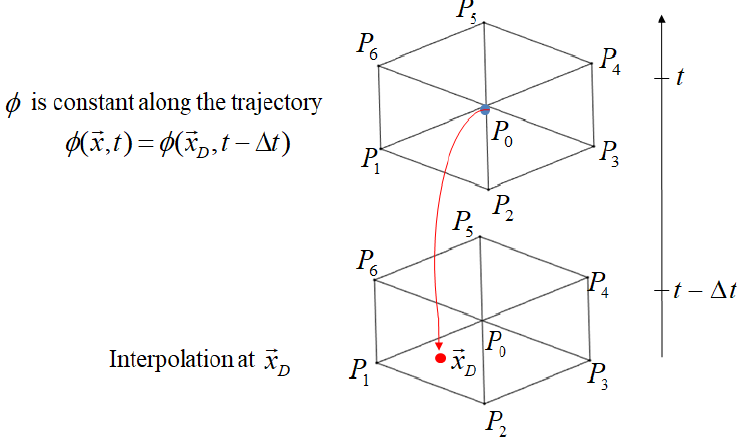
Figure 2. The main idea of a SL method. For a specific vertex P 0 , its departure point is denoted by → x D , the red curve denotes a characteristic curve. The value at arrival point P 0 at current time level just originates from the value at its departure point at the previous time level.